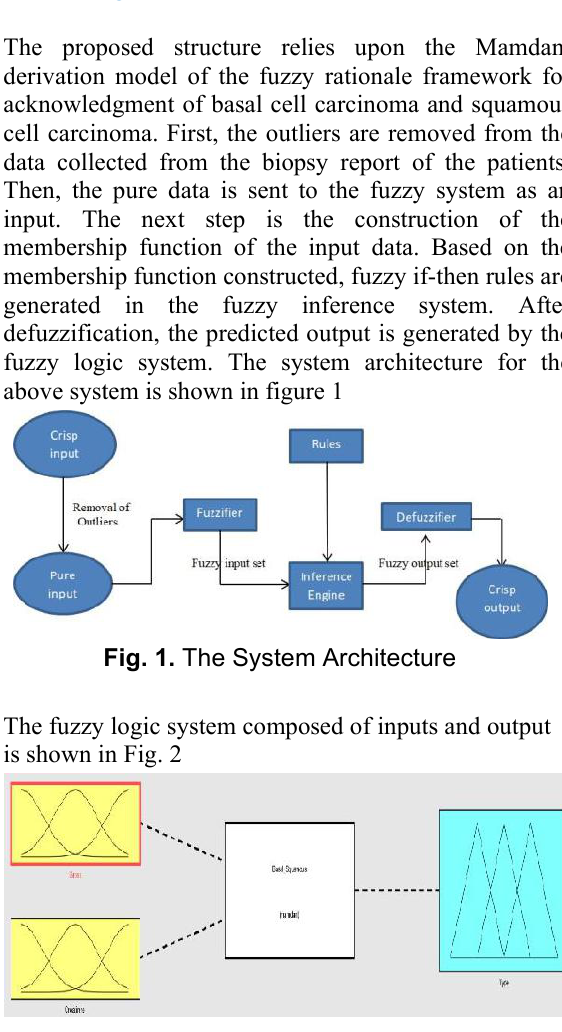
Fig. 3. Membership function plot for output Type